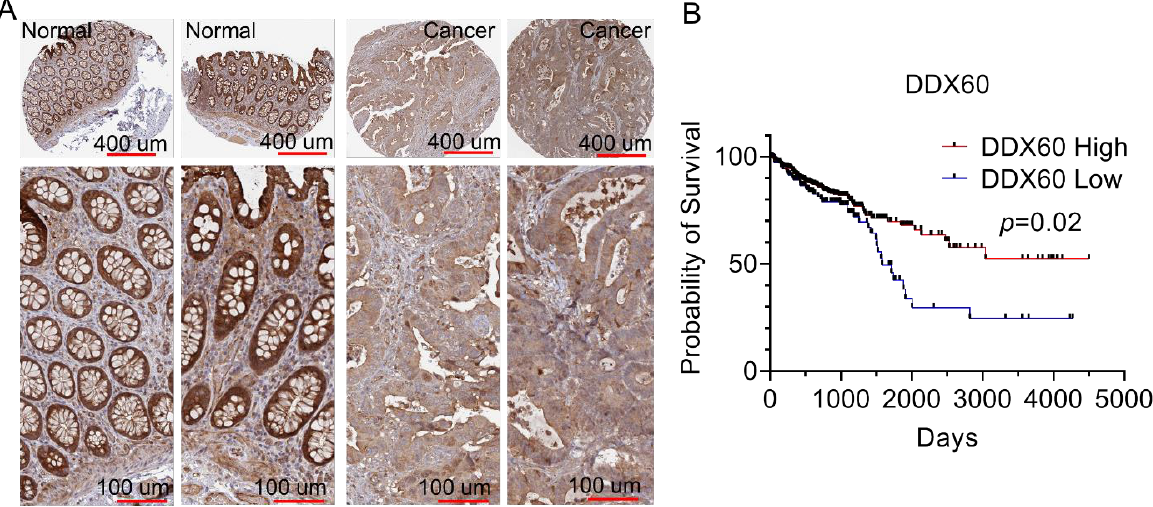
Figure 5. DDX60 is downregulated in CRC and its expression is associated with patient prognosis. ( A , B ). Immunohistochemical staining images showing the expression level of DDX60 in normal and cancerous tissue. Data were obtained from Protein Atlas (https://www.proteinatlas.org/, accessed on 14 January 2022) ENSG00000137628-DDX60/pathology/colorectal+cancer. ( B ) Kaplan–Meier